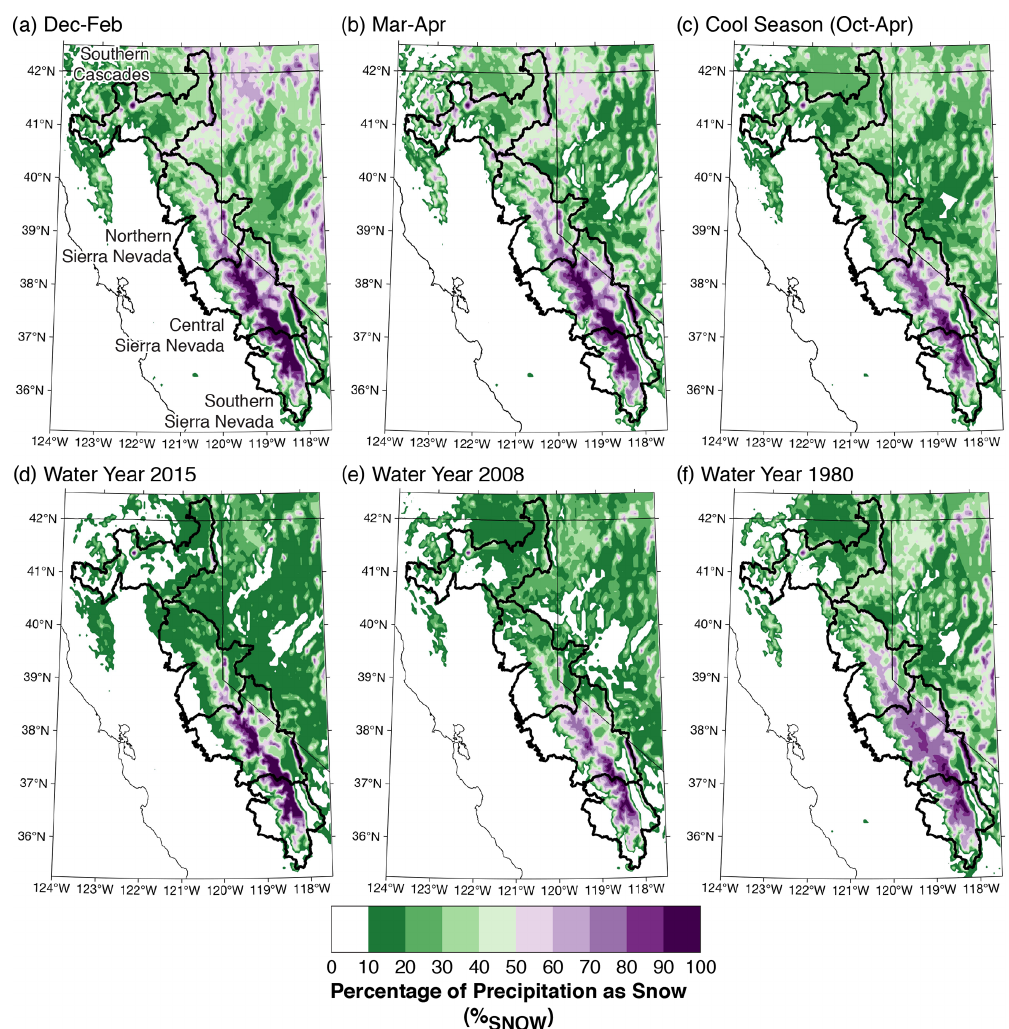
Figure 1. Estimated historical (1950–1969) percentages of precipitation as snow for (a) winter (December–February), (b) spring (March– April), and (c) for the full cool season (October–April). Examples of % SNOW averaged over the cool season (October–April) of water years (d) 2015, (e) 2008, and (f) 1980. Thick black contours denote California Department of Water Resources analysis